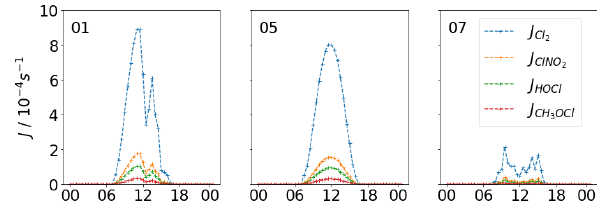
Figure 5. Diurnal profile for 1 November of (a) idealised J Cl and 2 P (Cl), (b) scaled J Cl and P (Cl), and (c) the difference between 2 (a) and (b) . Transmission efficiency scaled photolysis reduce P (Cl) from Cl 2